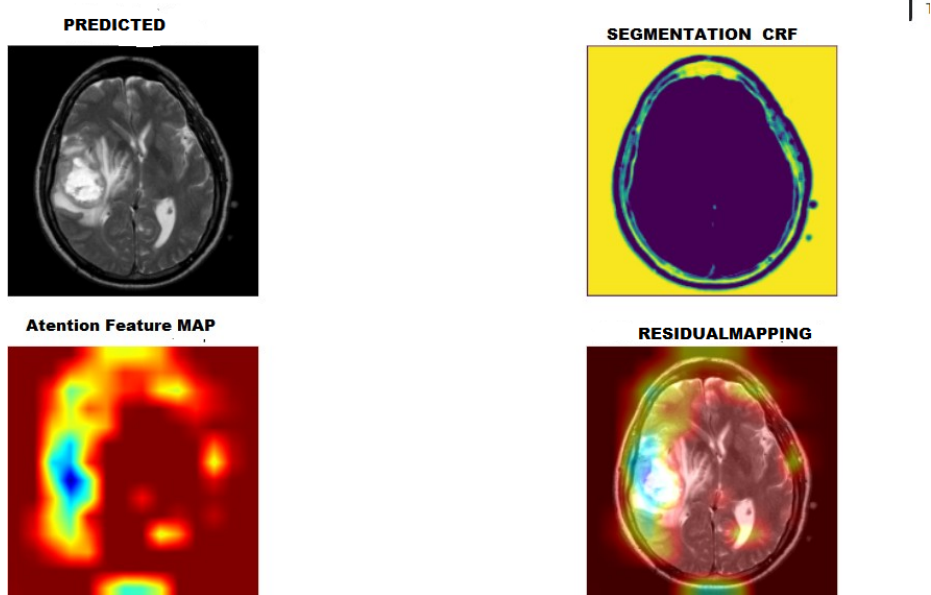
Figure 3. Three-Classes Detection Phases: Segmentation, Attention Mechanism and